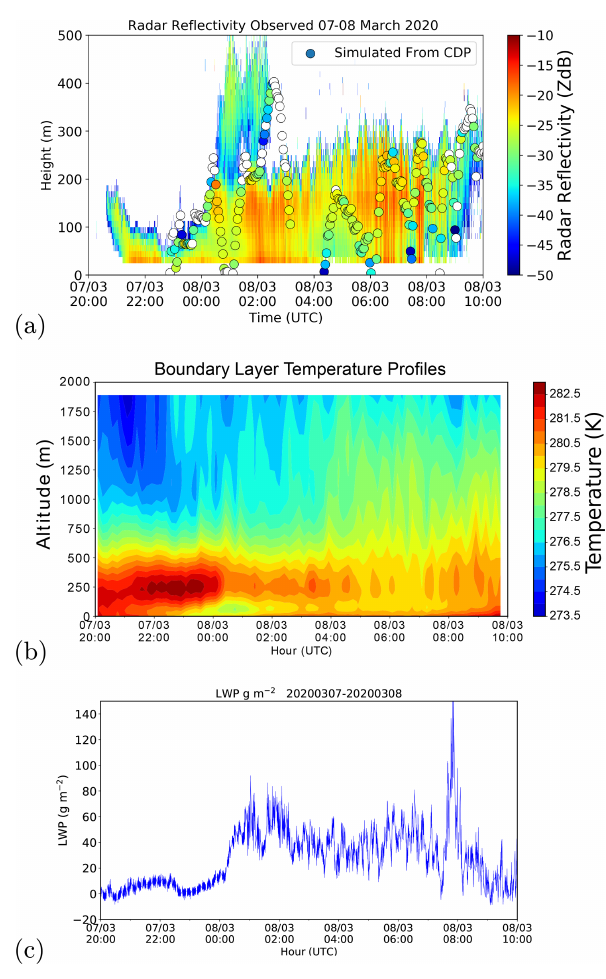
Figure 6. Time series of (a) radar reflectivity observed by the BASTA cloud radar in the background and the equivalent radar reflectivity factor simulated from measurements of LWC; droplet number concentrations made with the CDP are shown as coloured circles. Retrievals of (b) temperature profiles and (c) the LWP from the HATPRO microwave radiometer for the fog event observed on 7–8 March